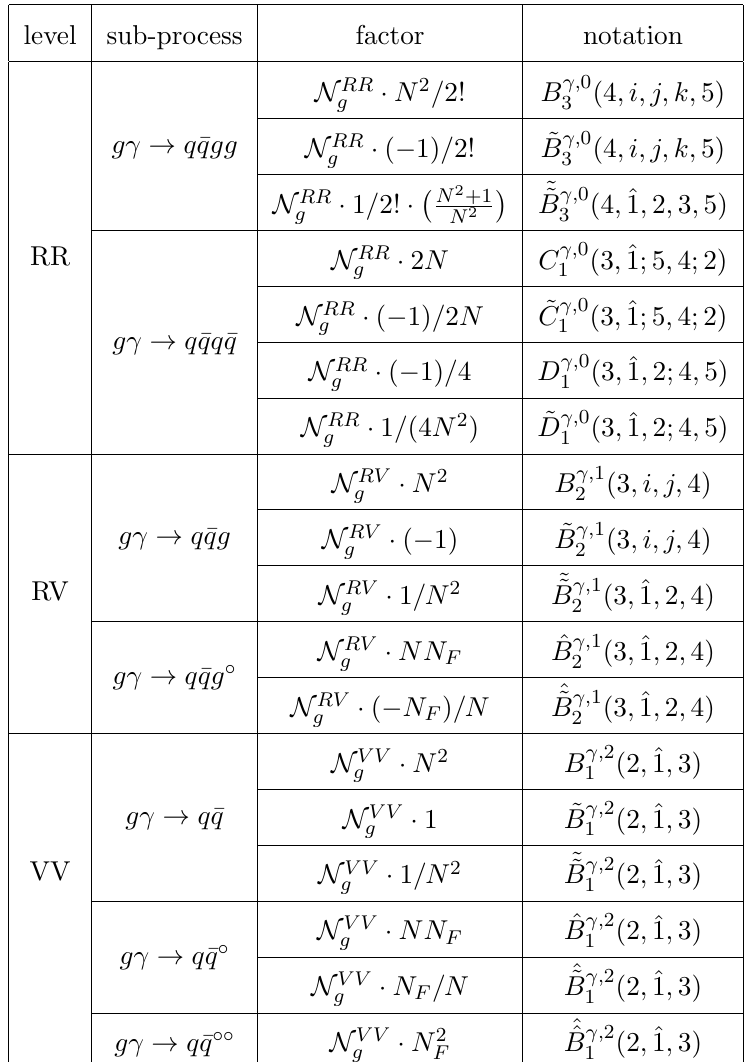
Table 5 . Summary of the gluon-channel partonic sub-processes and colour factors for the NNLO calculation. Non-numeric arguments denote summation over the set of gluons, which may include the initial-state gluon. e.g. the (cid:12)ve-parton matrix element B (cid:13); 0 the permutations f i; j; k g 2 P (^1 ; 2 ; 3). The four-parton matrix element B (cid:13); 1 sum over f i; j g 2 P (^1 ; 2). Each (cid:14) denotes a closed quark